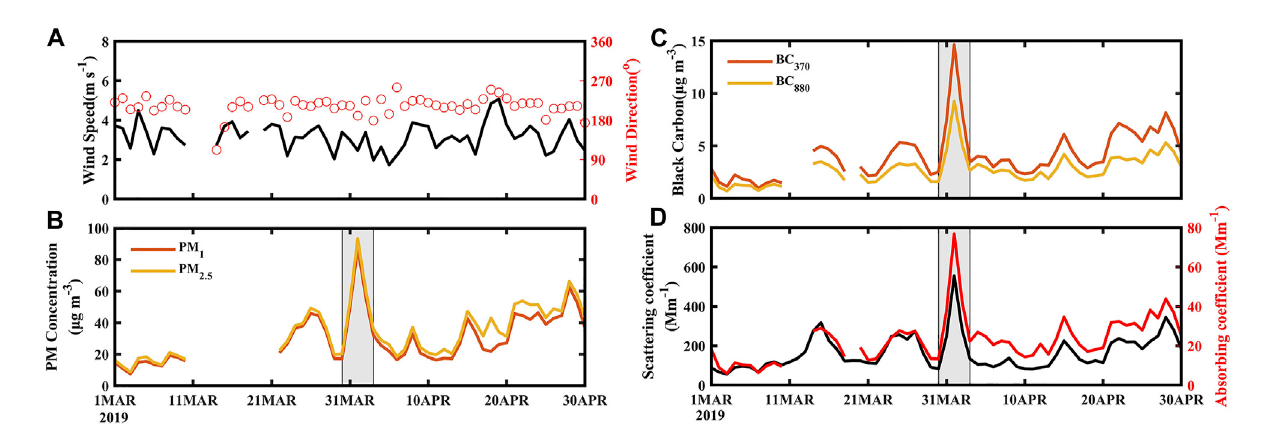
FIGURE 2 Daily mean observations of (A) wind speed (m s − 1 ) and wind direction ( ° ), (B) PM 2.5 and PM 1 concentrations ( μ g m − 3 ), (C) BC 370 and BC 880 concentrations ( μ g m − 3 ) and (D) aerosol scattering coef fi cient (525 nm) and absorbing coef fi cient (532 nm) (Mm − 1 ) at the Chenggong station from 1 March to 30 April 2019. The pollution episode occurred from 30 March to 2 April 2019 is denoted by the grey shaded area.